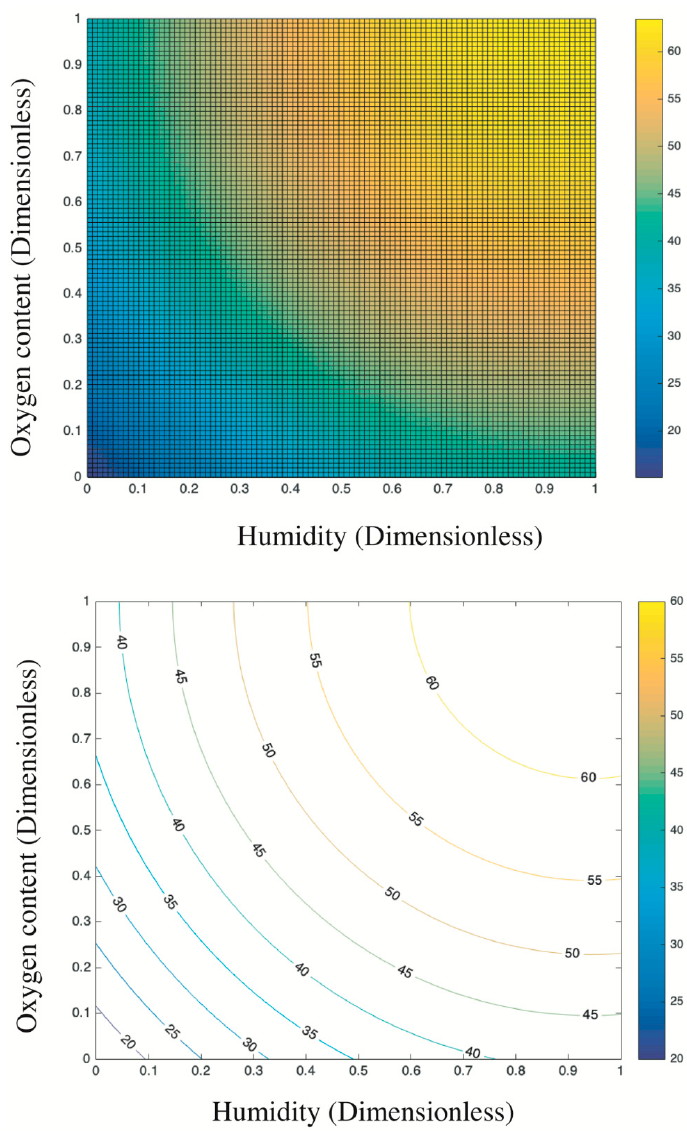
Figure 10. Contour plots of estimations: top view of the trend surface ( upper ); and the quantitative contour plot (lower).